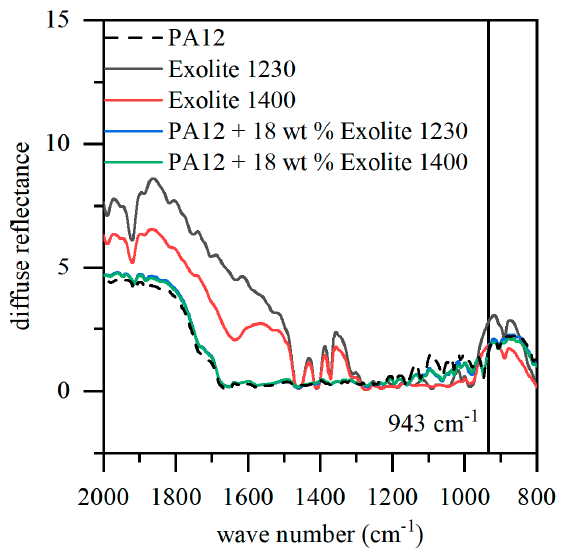
Figure 4. Diffuse reflectance infrared spectra of filler, PA12 powder, and composite powders.